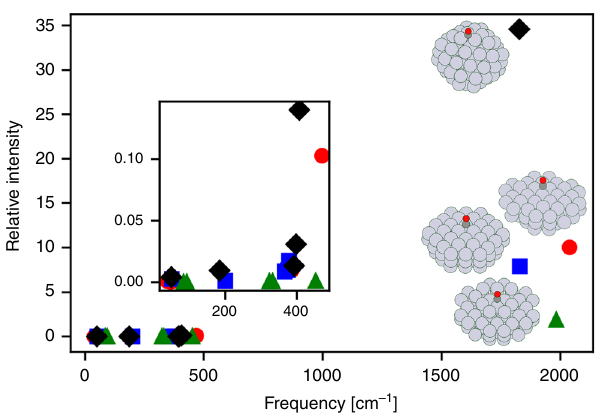
Fig. 2 DFT frequencies and corresponding intensities for an adsorbed CO on different sites. Data for atop site of Pt 68 with a GCN of 7.5 (red circles), atop site of Pt 78 with a GCN of 8.42 (green triangles), bridge site of Pt 72 with a GCN of 7.33 (blue squares), and bridge site of Pt 79 with a GCN of 3.5 (black diamonds). The subscript refers to the number of Pt atoms. The inset is a zoomed in image of the Pt – CO and Pt – CO frequencies in our dataset (2019 and 446 cm − 1 ),